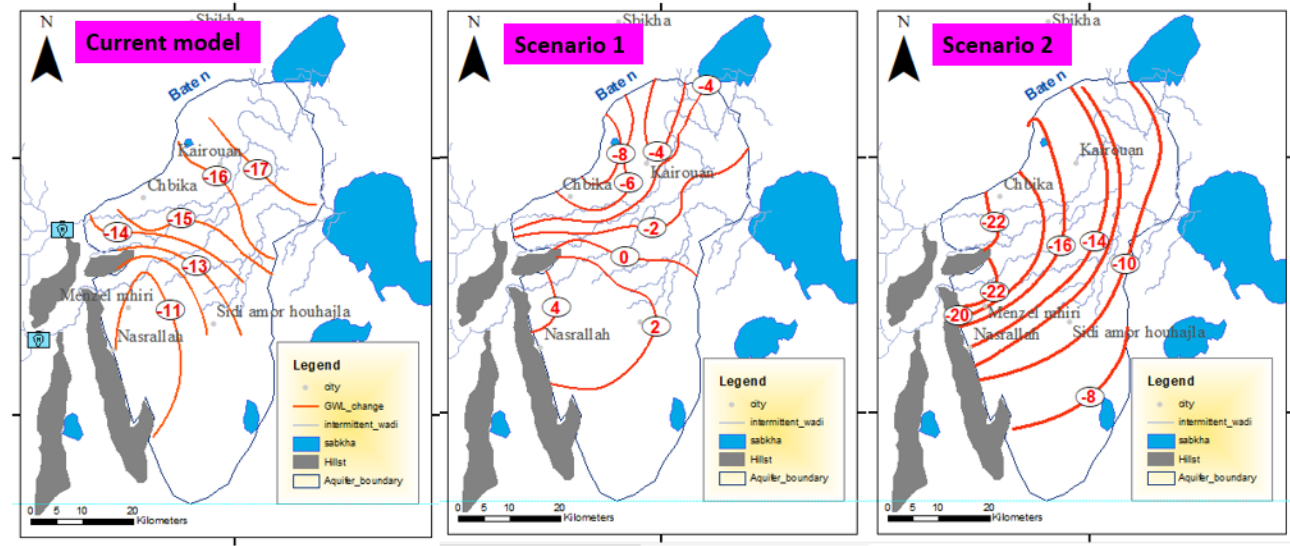
Figure 11. GWL change between 1969–2017 for the current model, scenario 1 and scenario2.